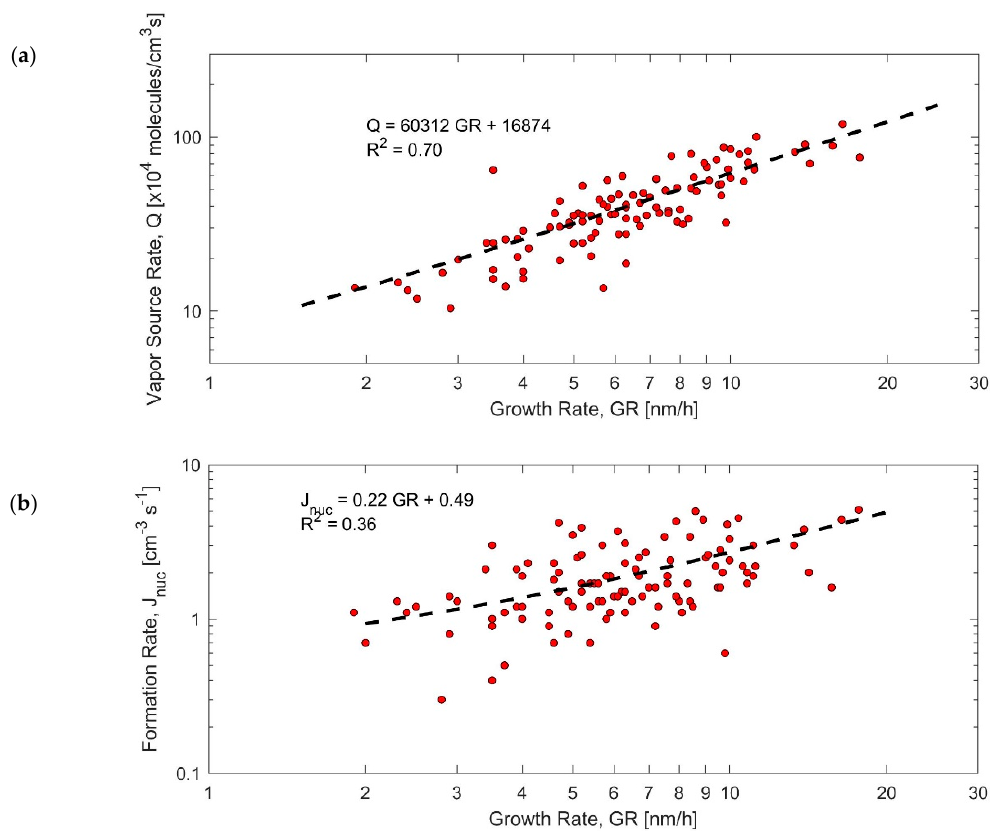
Figure 7. Correlation plots ( a ) condensable vapor source rate ( Q ) (daily means) versus modal growth rate ( GR ) during NPF events and ( b ) f ormation rate ( J 10 ) (daily means) versus growth rate ( GR ) during NPF events.